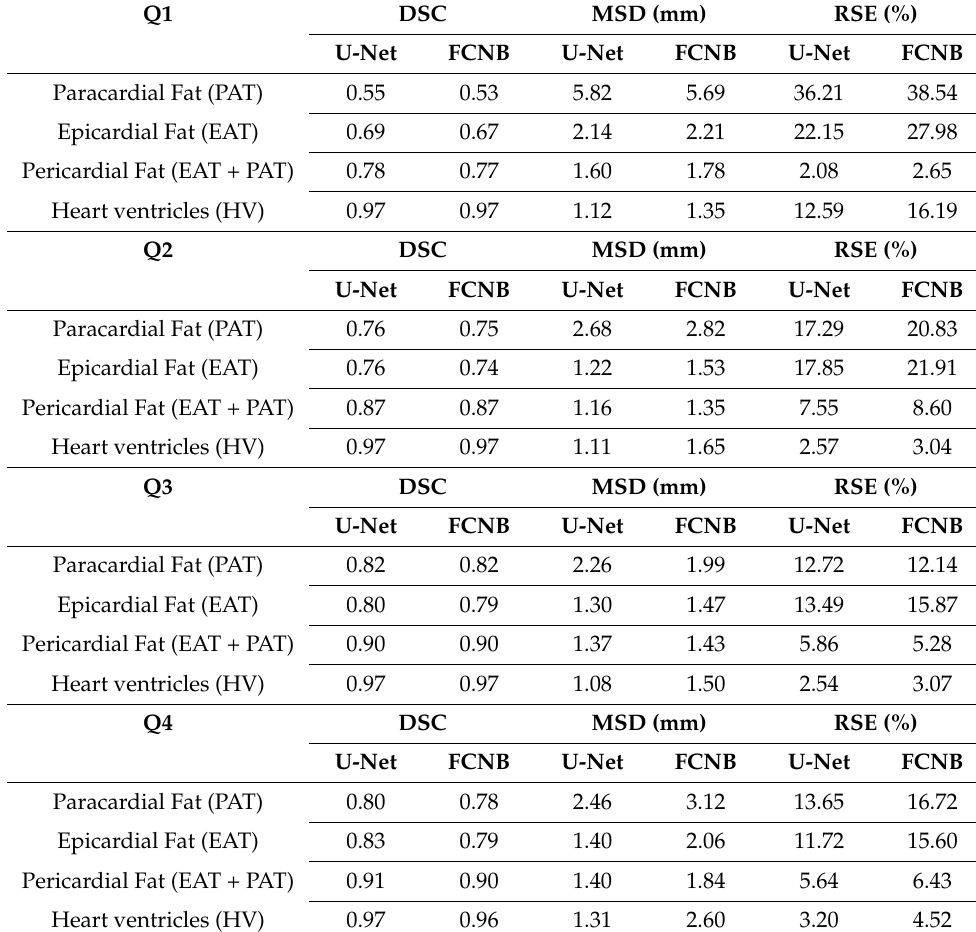
Table 3. DSC, MSD, RSE metrics evaluated per quartile (Q1-Q4) of EAT area for U-Net and